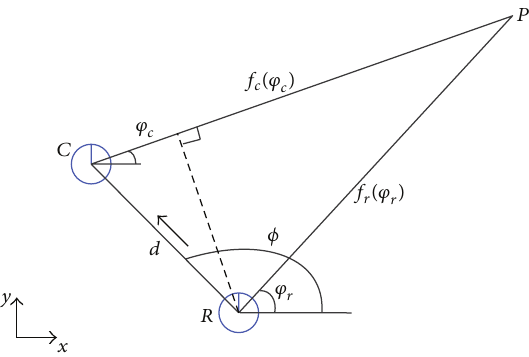
Figure 4: Translation of the mobile